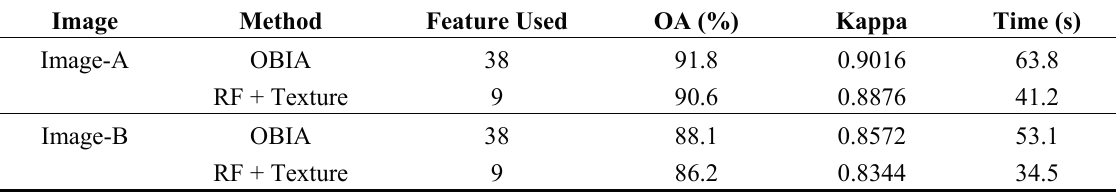
Table 2. Comparison of OBIA and RF +